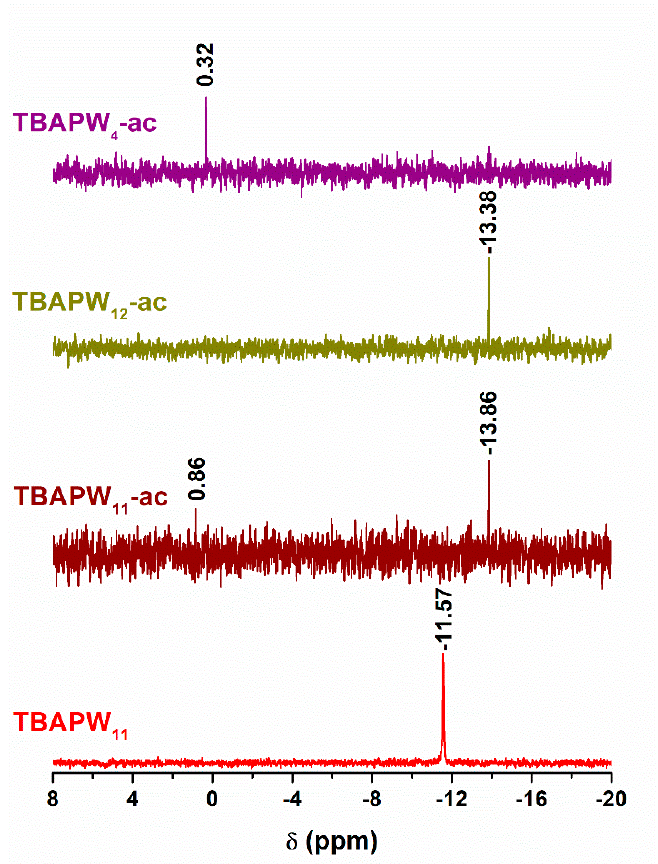
Figure 5. 31 P NMR spectra of as-synthetized TBA[PW 11 ] and TBA[PW 11 ], TBA[PW 12 ] and TBA[PW 4 ] after catalytic use (ac).